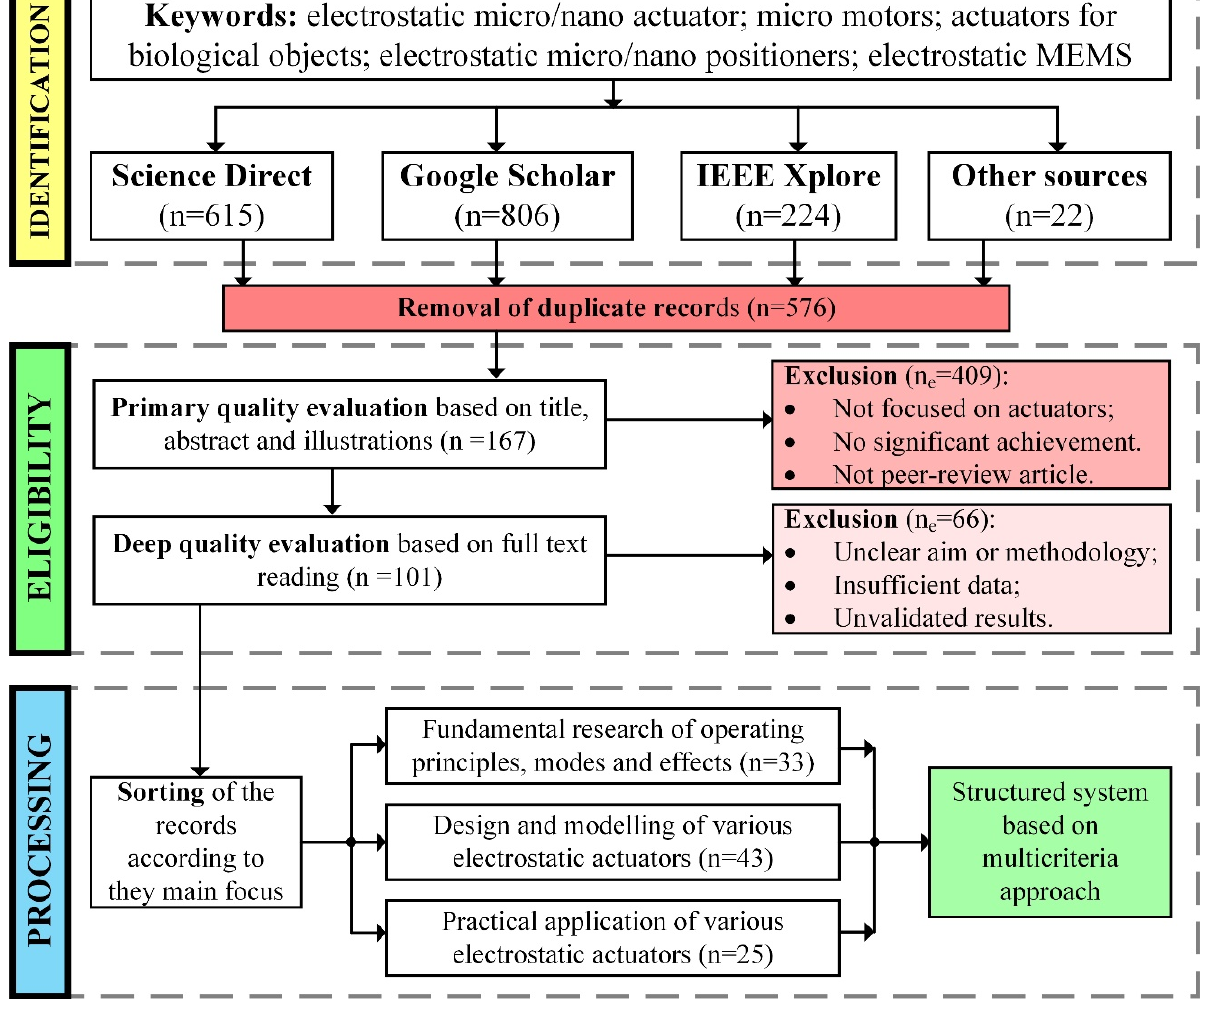
Figure 1. The methodology of review; n—number of articles.